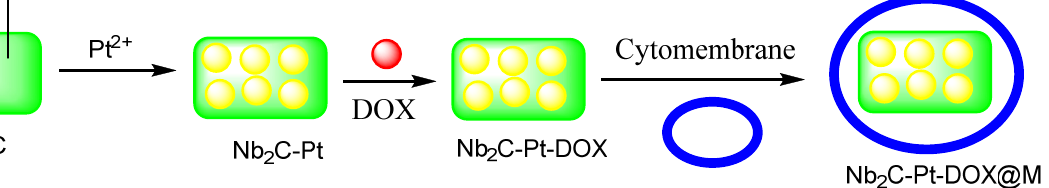
Figure 2. Schematic diagram of MXene-based biomimetic plasmonic assembly for targeted cancer therapy [94].